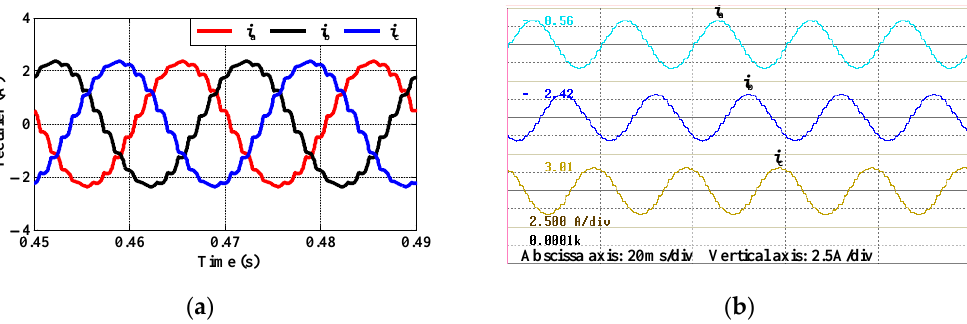
Figure 12. Input voltage of the proposed rectifier with the reduction method. ( a ) Simulation result. ( b ) Experimental result. Figure 13 expresses the input currents when without suppression method. In Figure 13, the simulated THD is about 7.4%, and the experimental THD is about 5.8%.